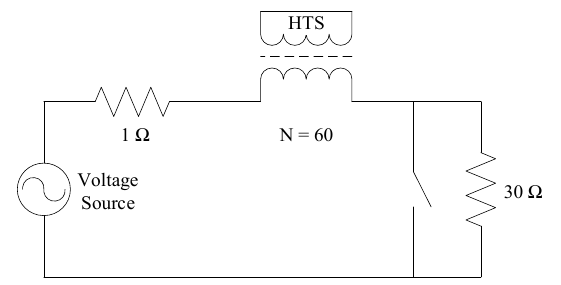
Fig. 4. Diagram of the test circuit. Short-circuit faults are intentionally induced by nulling the load, which is carried out by closing the circuit-breaker.